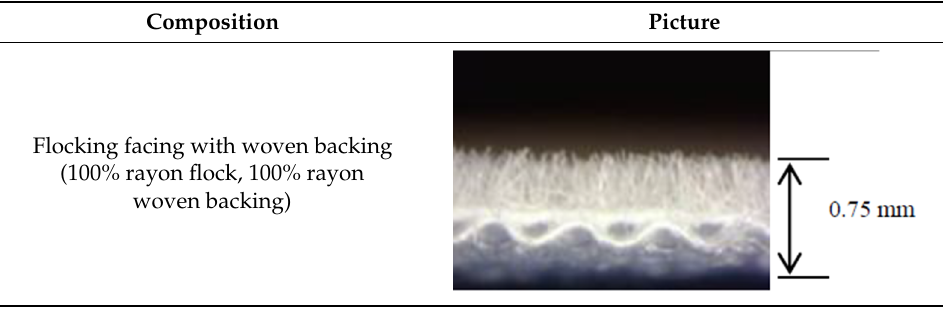
Table 1. Basic information of rayon flock synthetic leather [20].